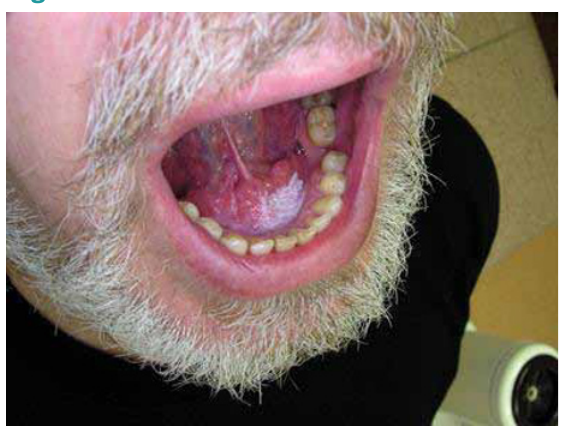
Figure 2. 4 weeks after ablation